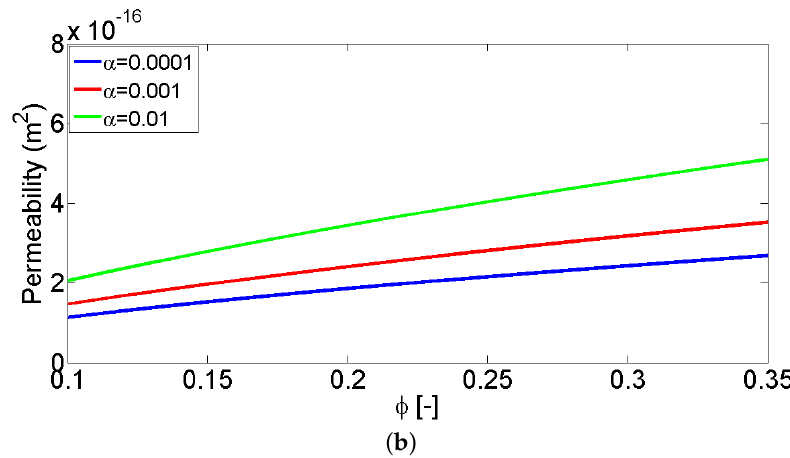
Figure 4. The variation of the permeability of fractured media k with the fracture aspect ratio β and porosity φ predicted from Equation (15) for three values of α (0.0001, 0.001 and 0.01) with representative values of w max = 200 × 10 − 6 m, τ = 1.2: ( a ) φ is fixed at 0.15; ( b ) β is fixed at 0.001.